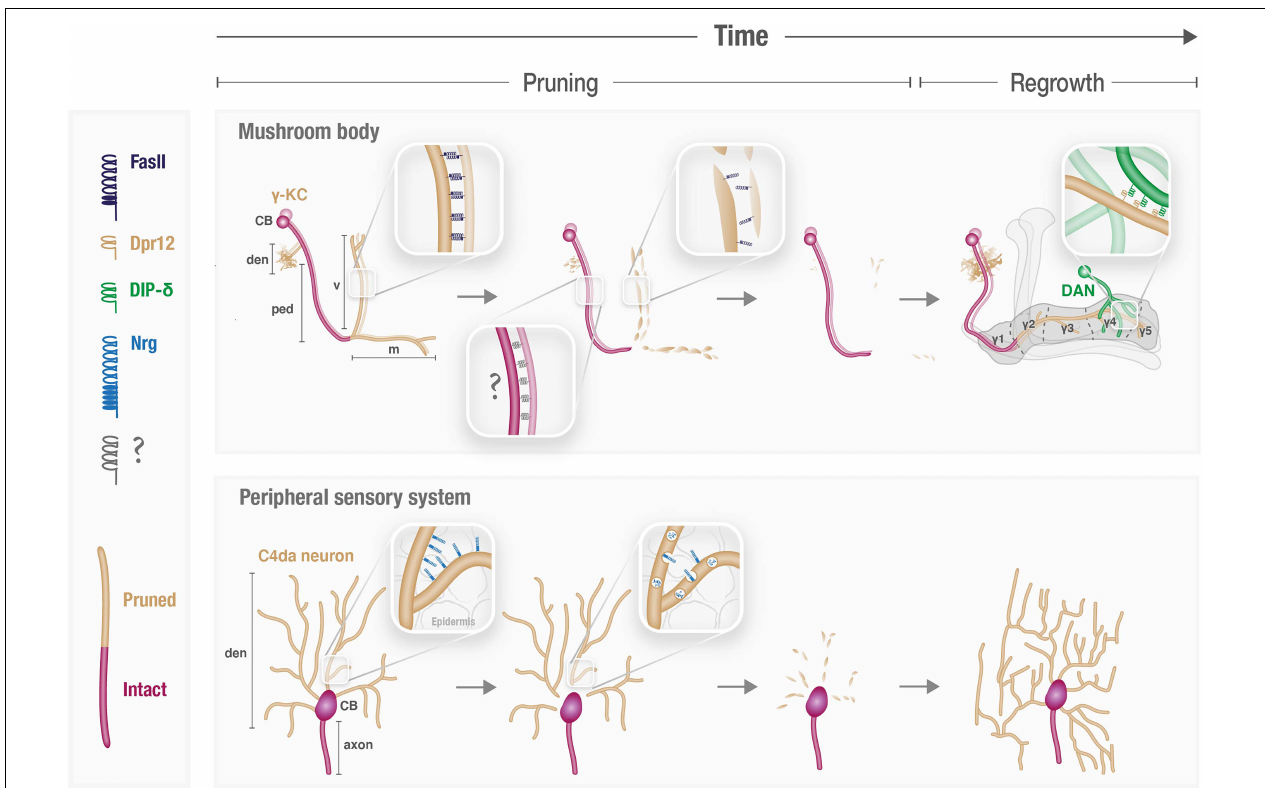
FIGURE 1 | Cell adhesion molecules participate in spatiotemporal control of neuronal remodeling. Schematic illustration of the known and speculated roles of CAMs during pruning and regrowth of the γ -Kenyon cells (KCs) in the mushroom body (MB) and peripheral sensory Class 4 (C4) da neurons. CB, cell body; den, dendrites; ped, axon peduncle; v and m, vertical and medial axonal branches,